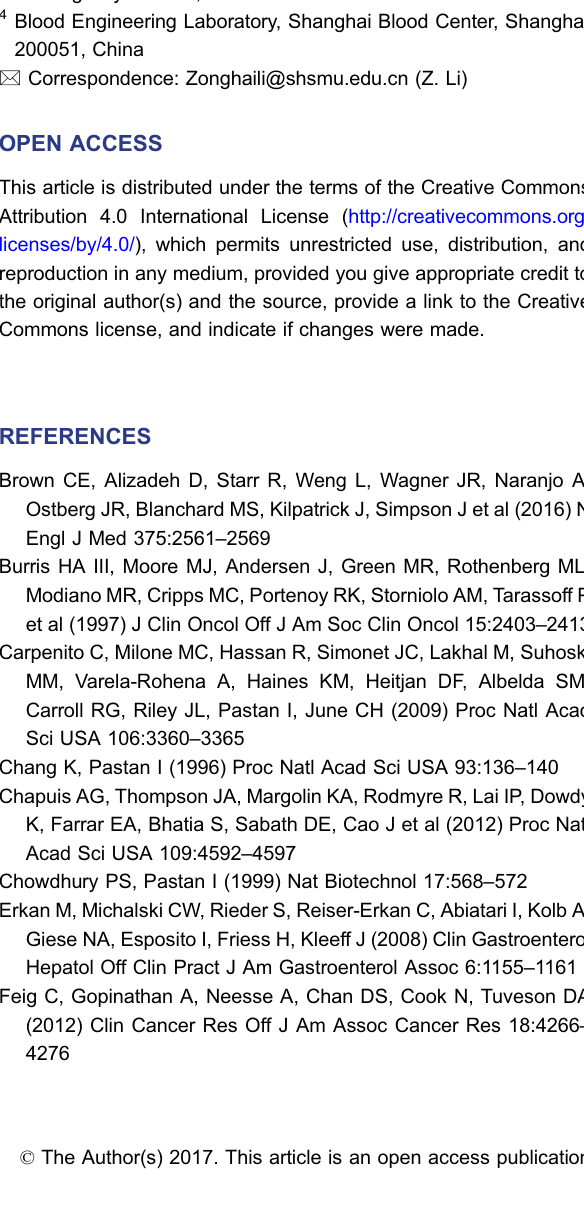
tumors on day 0. On day 30, when the tumor volumes